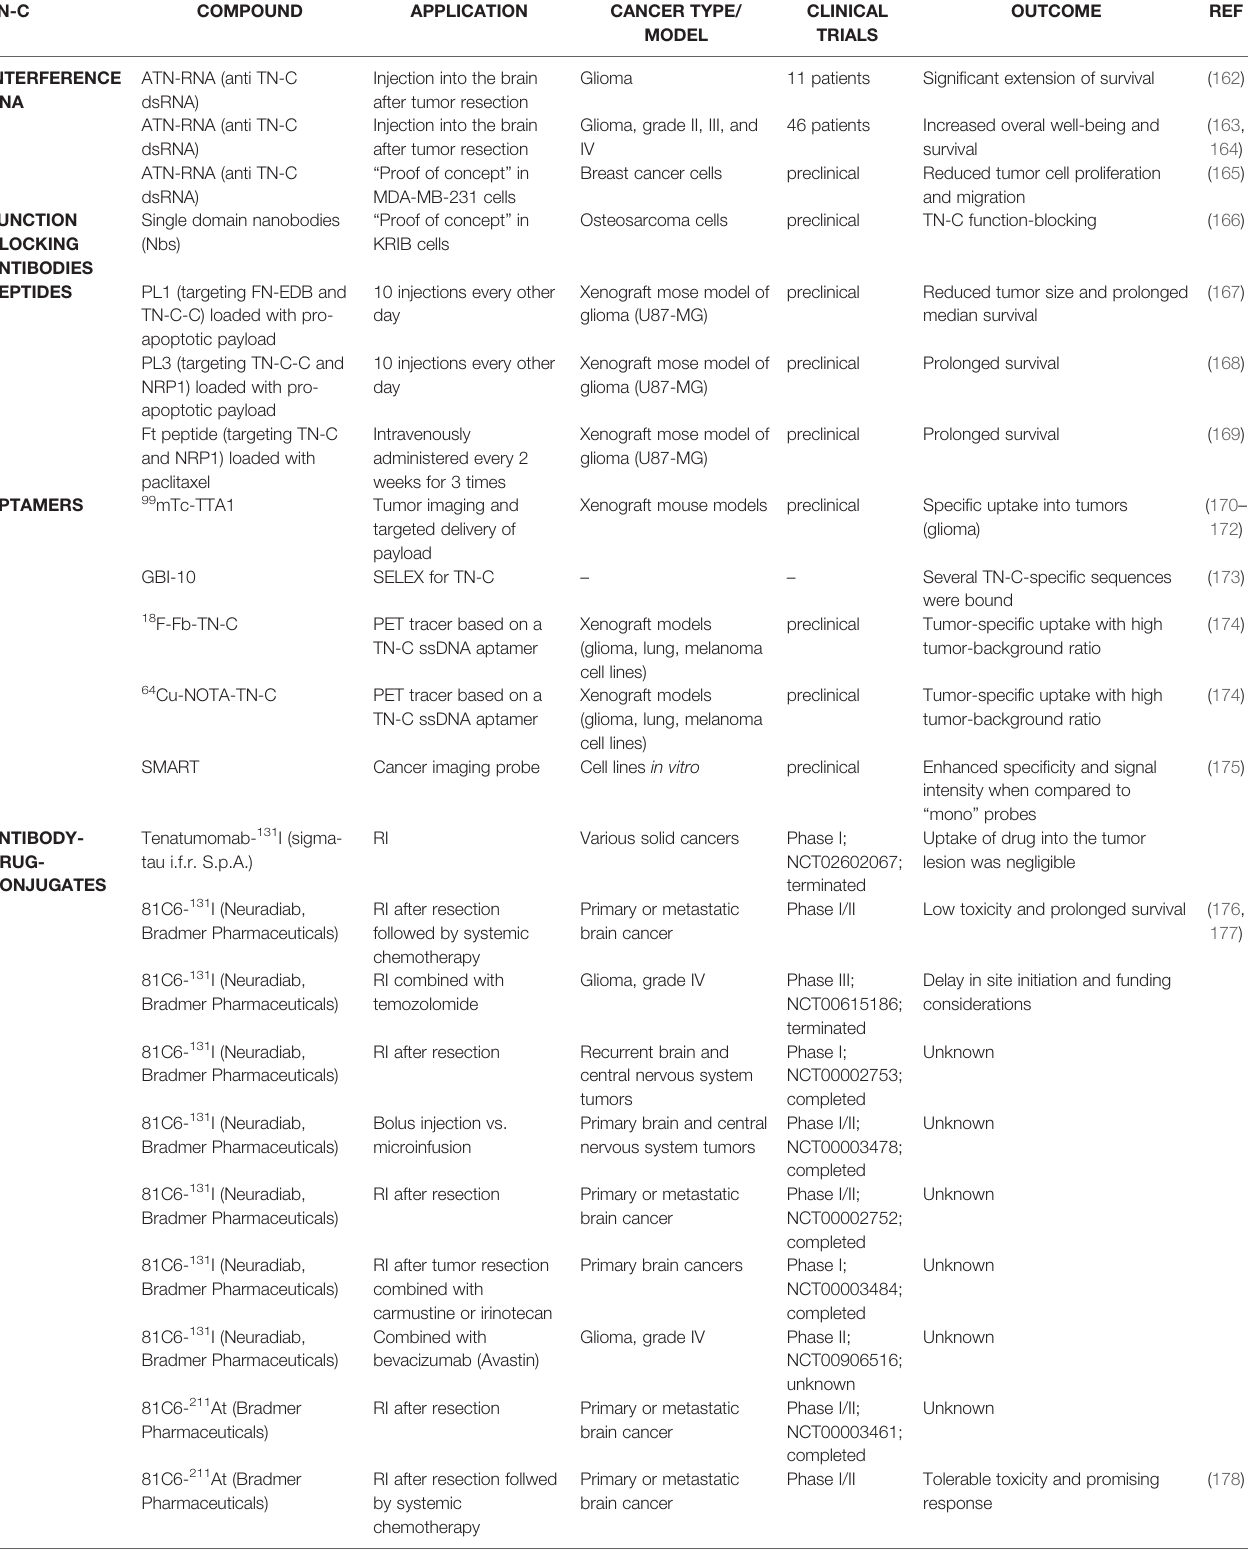
TABLE 1 | Strategies for targeting TN-C in cancer